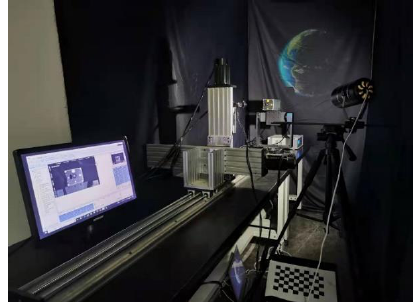
Figure 9. Semiphysical simulation platform.